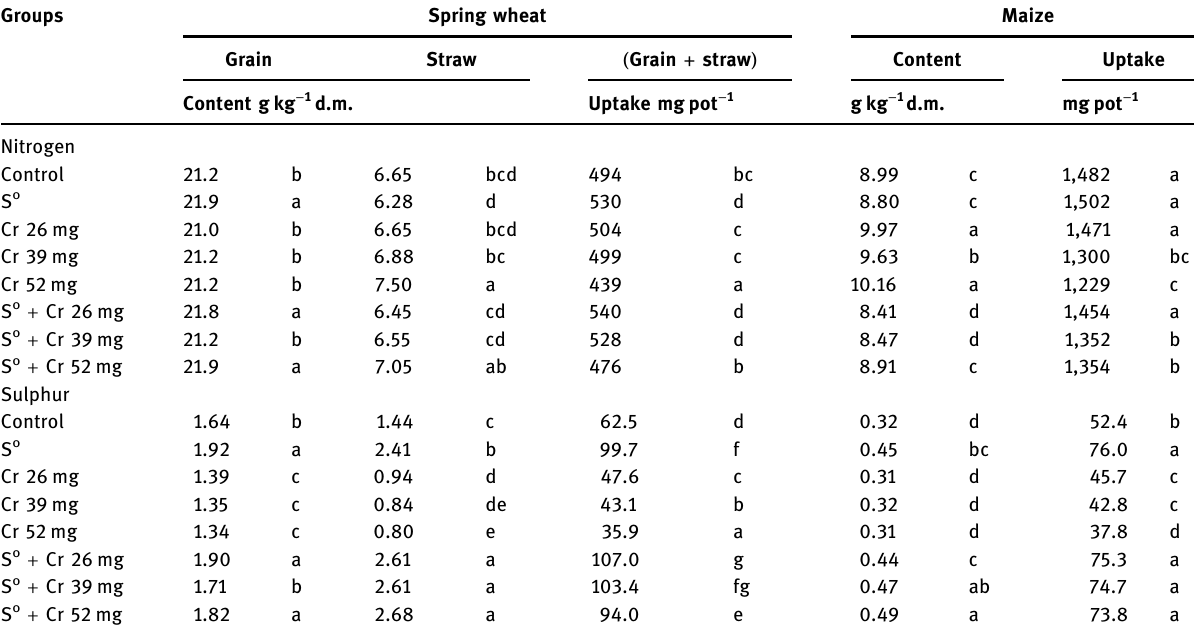
Table 3: Nitrogen and sulfur content and uptake in cultivated plants Groups Spring wheat Maize Grain Straw ( Grain + straw ) Content Uptake Content g kg − 1 d.m. Uptake mg pot − 1 g kg − 1 d.m. mg pot − 1